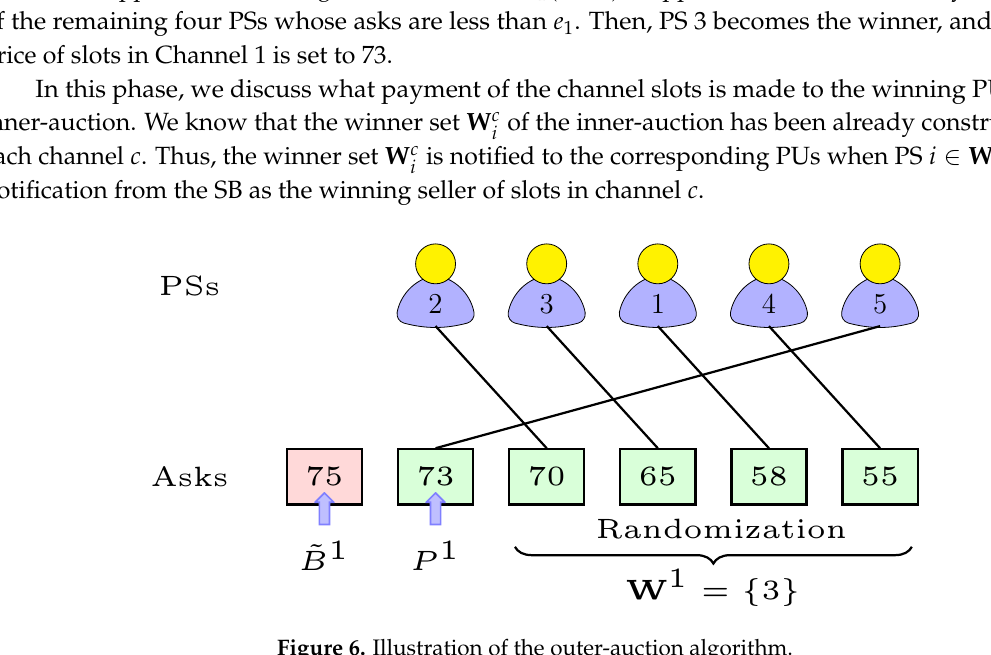
Figure 6. Illustration of the outer-auction